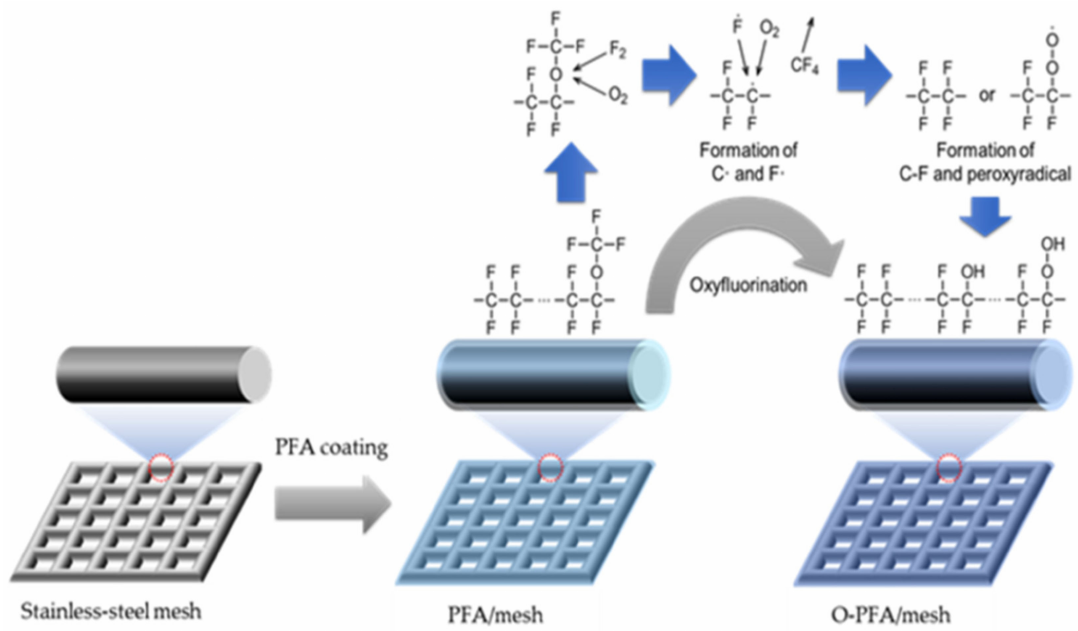
Figure 4. The proposed mechanism of surface modification on PFA-coated mesh by oxyfluorination.